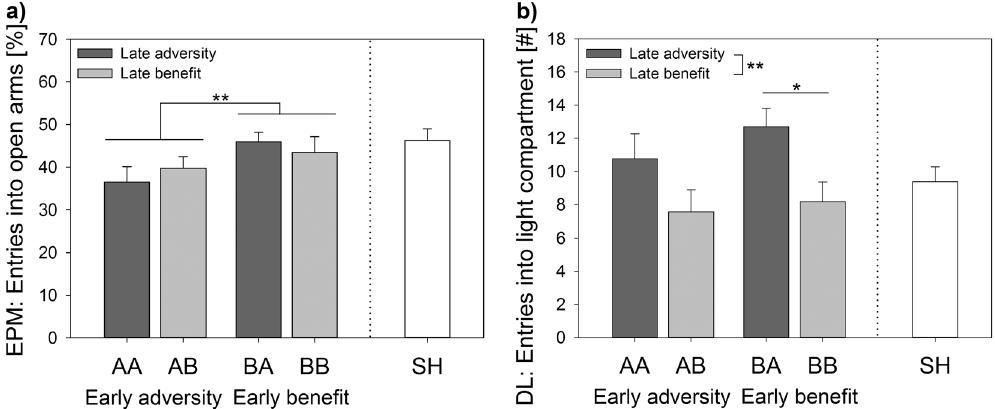
Figure 3. Anxiety-like behaviour and exploratory locomotion. ( a ) Percentage of entries into open arms of Elevated plus-maze (EPM) test and ( b ) Entries into light compartment of Dark-light (DL) test displayed by mice grown up in an early adverse (AA and AB) or beneficial (BA and BB) environment and provided with later matching (AA and BB) or mismatching (AB and BA) conditions in adulthood. Sham-handled mice (SH) served as control. There was a significant main effect of the early phase on the percentage of entries into the open arms (p = 0.042) as well as a significant main effect of life history (p = 0.031) and the late phase (p = 0.005) on the entries into the light compartment. Data are given as means + s.e.m. Statistics: ANOVA, Bonferroni post-hoc testing. * p ≤ 0.05; ** p ≤ 0.01. n =